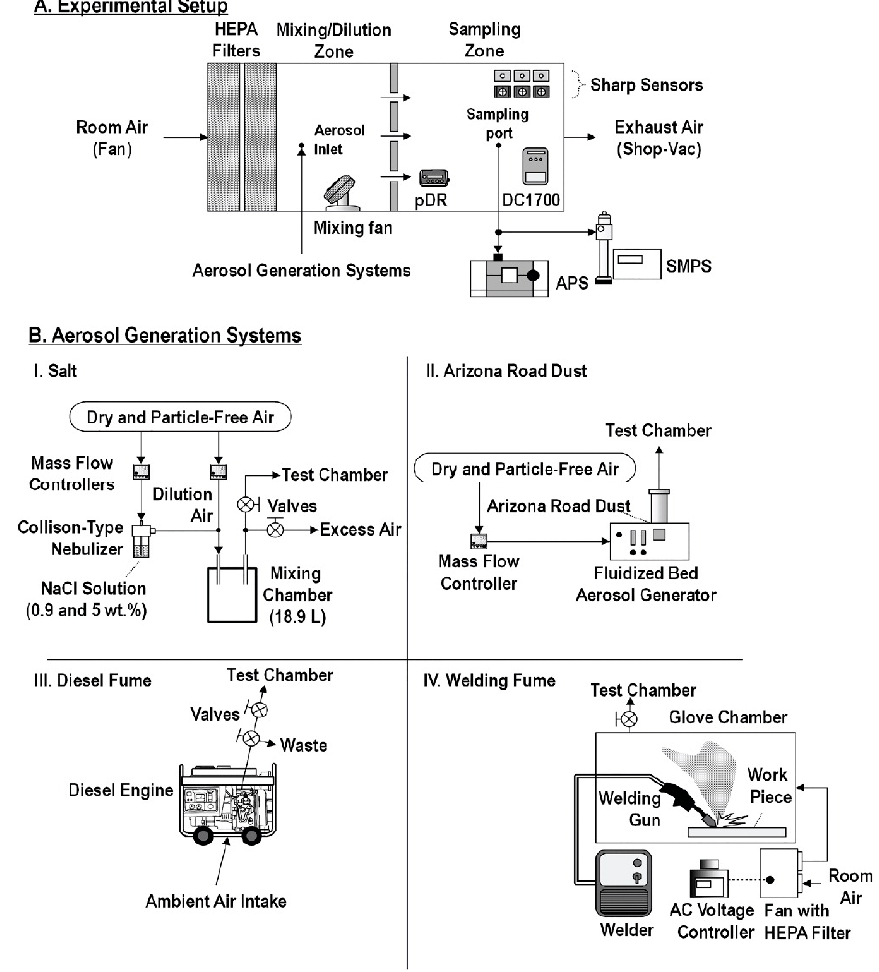
Figure 9. Experimental set up used by Peter’s group (2016) ( A ). Schematics of the aerosol generation systems shown in panel ( B ) (image reprinted with permission provided by the Taylor and Francis and Copyright Clearance Center—License Number 4836480661138).